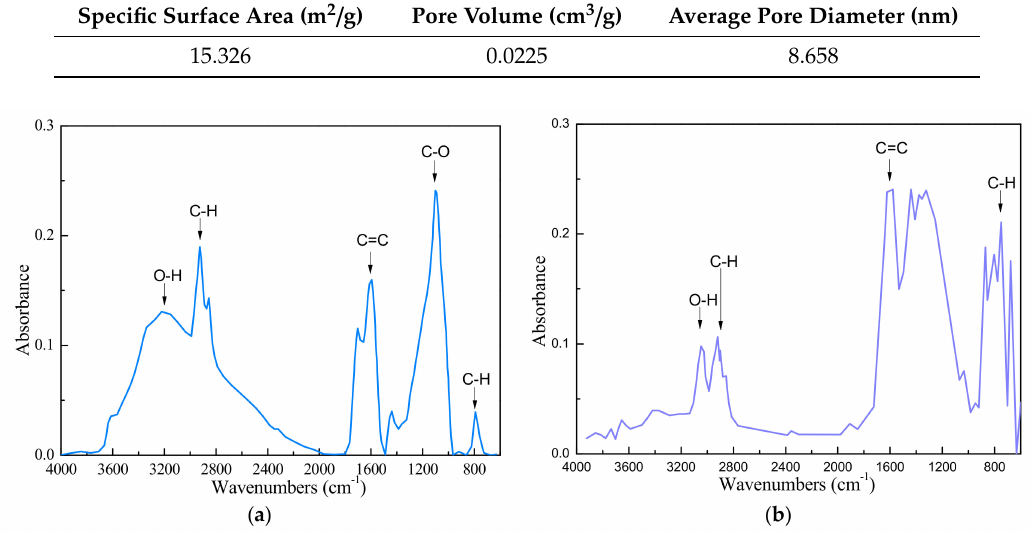
Figure 2. FTIR(Fourier Transform Infrared Spectroscopy) result of LRC sample ( a ) and anthracite sample ( b ).